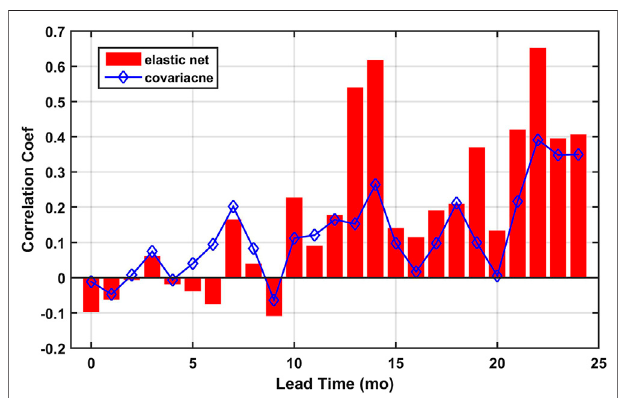
FIGURE 6 | Comparison between the predictive skill from the elastic net model (bar) and L s (blue diamond) at varying lead times. The statistical signi fi cance levels are not shown here as we are comparing correlation coef fi cients calculated using samples of different lengths (19 for the predictive skill and 39 for the L s).